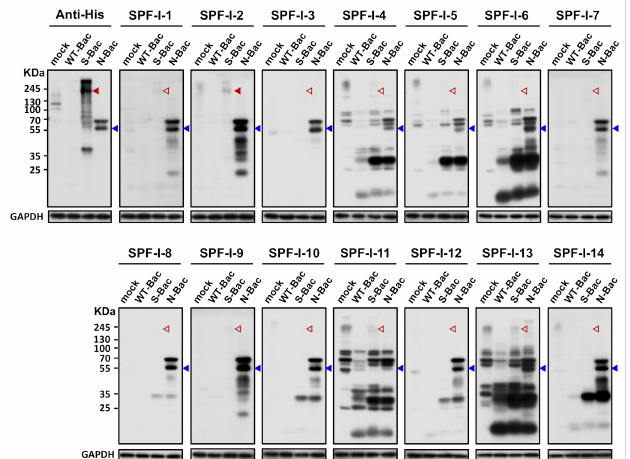
Figure 3. Western blot analysis reveals weak/absent anti-S antibody signals in PEDV-positive piglet sera. Uninfected Sf21 cells (mock) and Sf21 cells infected with WT-Bac, S-Bac, and N-Bac were subjected to Western blot analysis using piglet antisera. Primary antibody: anti-His antibody with a dilution of 1:5000 or PEDV-positive antiserum, SPF-I, with a dilution of 1:2000. Secondary antibody: goat anti-mouse IgG conjugated to HRP (1:5000 dilution) or goat anti-swine IgG conjugated to HRP (1:5000 dilution). Arrowheads: red, anti-S signal; blue, anti-N signal. Empty arrowheads represent an apparent lack of or weak anti-S